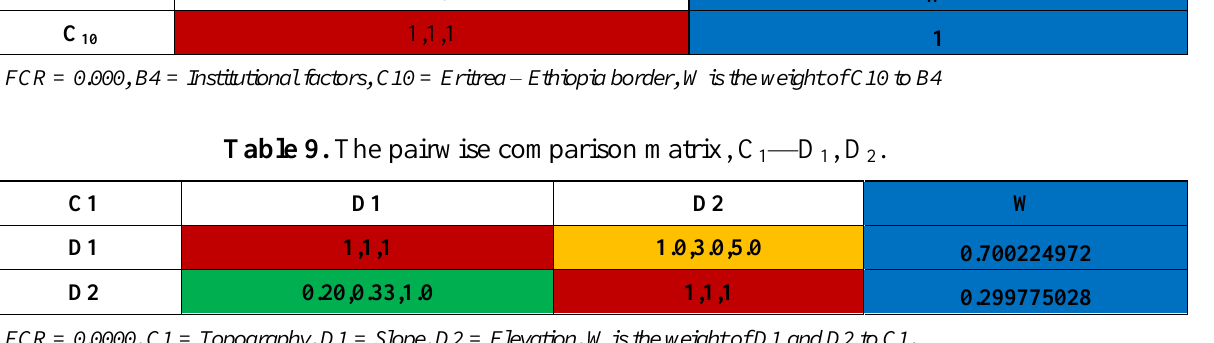
Table 10. The pairwise comparison matrix, C